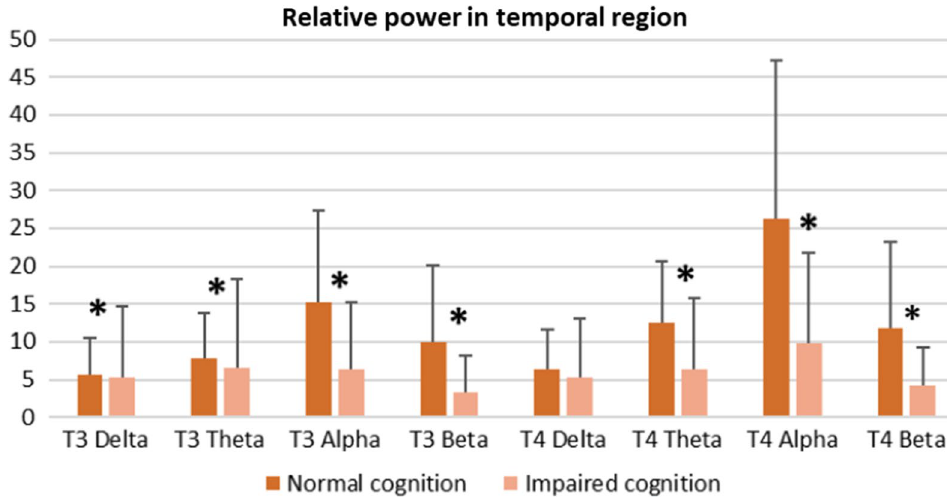
Fig. 3 Relative power in temporal region of the patients with normal and impaired cognition